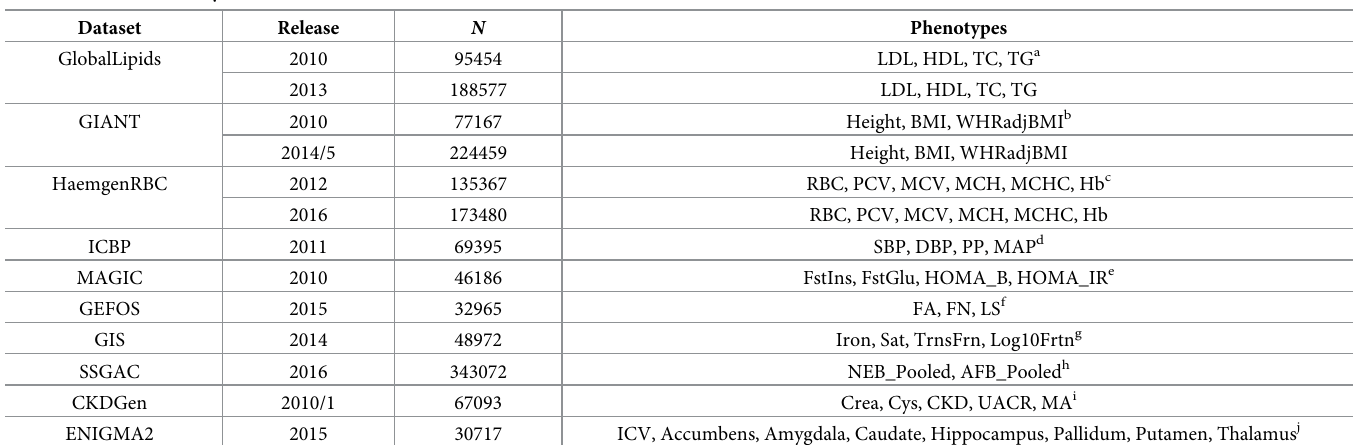
Table 1. Dataset